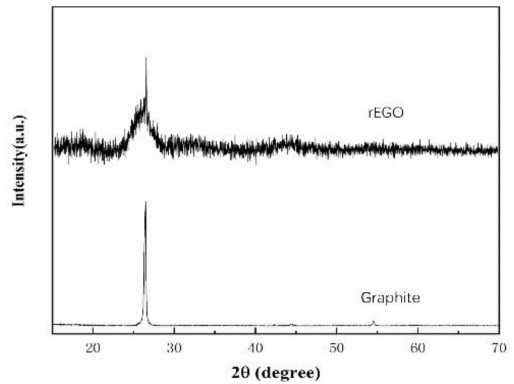
Figure 5. XRD diffraction spectra of graphite flakes and